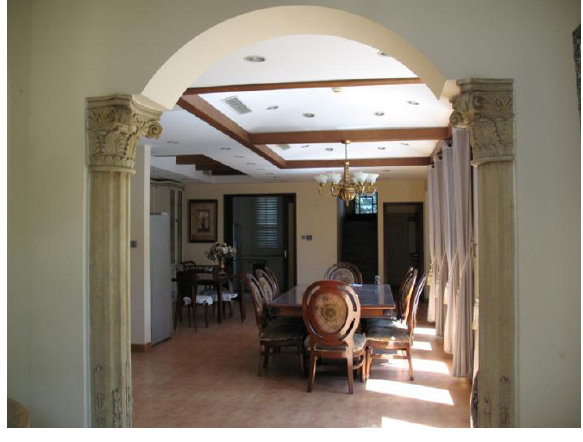
Figure 15. Living/dining room of a Beijing Guantang courtyard garden villa, designed, built, and furnished in classical Western architectural style. Photo: Donia Zhang 2014.